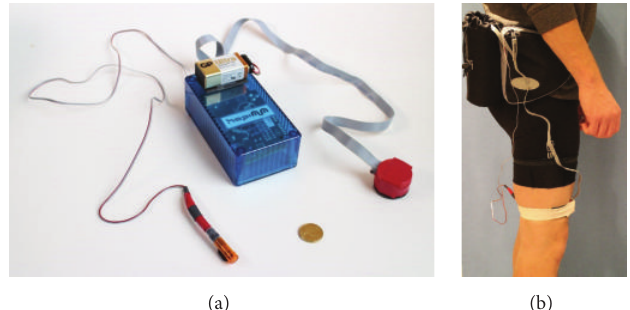
Figure 2: (a) Wearable parts of the apparatus including electronics in the enclosure box (middle), accelerometer inside the round housing (right), and vibration motor inside the tube housing (left). Scale is indicated by a coin in diameter of 20 mm. (b) The belt bag containing the enclosure box and the leg band equipped with the accelerometer and vibration motor worn by a